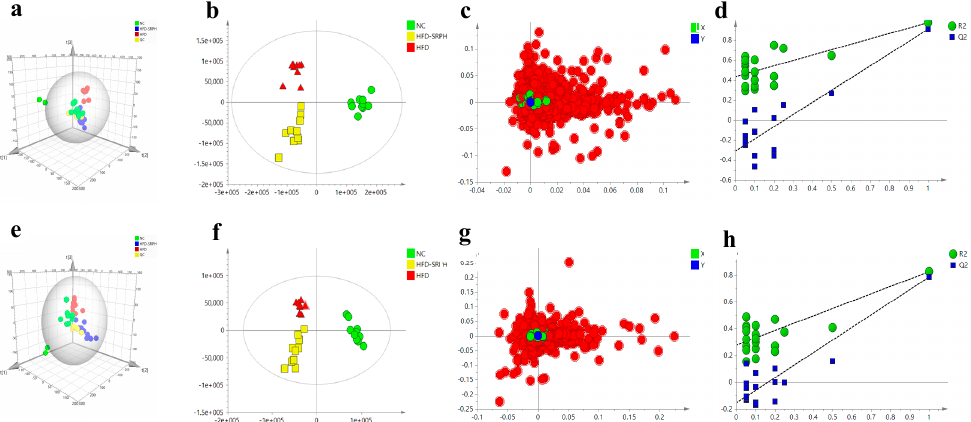
Figure 5. SRP changes fecal metabolome in HFD-fed rats. The LC/MS-based untargeted metabolic profiling in positive and negative modes was performed on fecal samples. ( a ) PCA of positive ion mode. ( b ) PLS-DA in positive ion mode. ( c ) Loading plot of positive ion mode. ( d ) Permutation plot of positive ion mode. ( e ) PCA of negative ion mode. ( f ) PLS-DA in negative ion mode. ( g ) Loading plot of negative ion mode. ( h ) Permutation plot of negative ion mode.